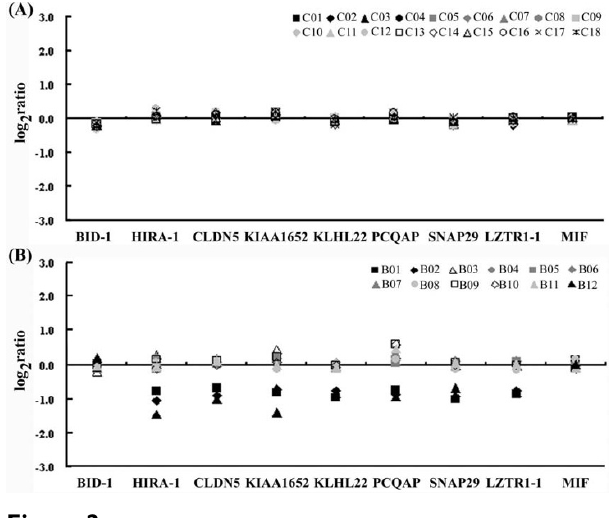
Figure 2 DNA dosage profiles estimated by MLPA analysis